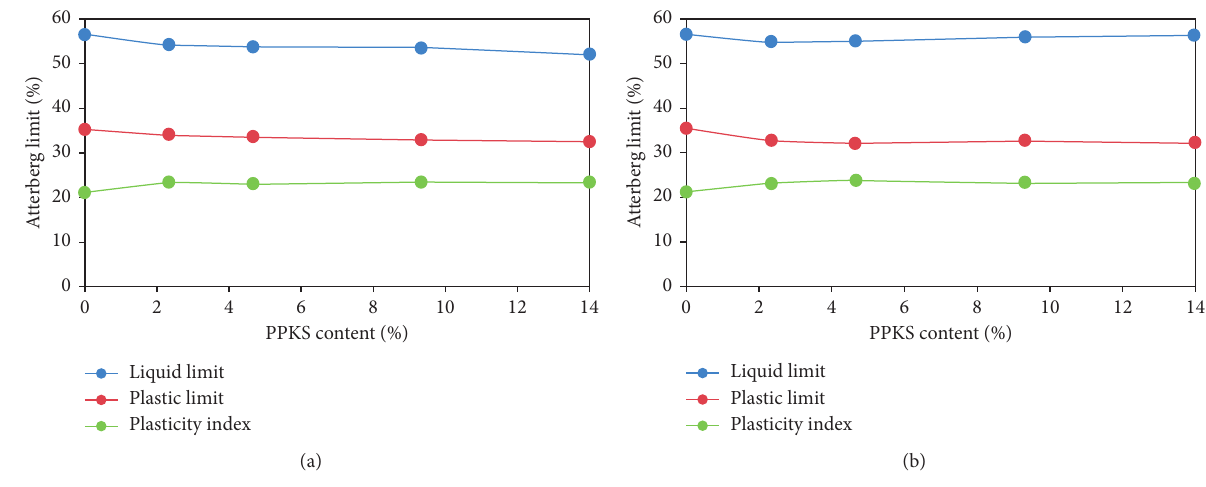
Figure 5: Atterberg limits versus PPKS and PKSA for the treated shale.